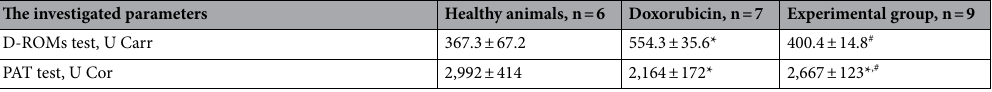
Table 1. Antioxidant effects of grape polyphenol concentrate. *P < 0.05 compare to the value in the group of healthy animals. # P < 0.05 compare to the value in the group of control animals. Results presented are mean ± standard error of the mean.